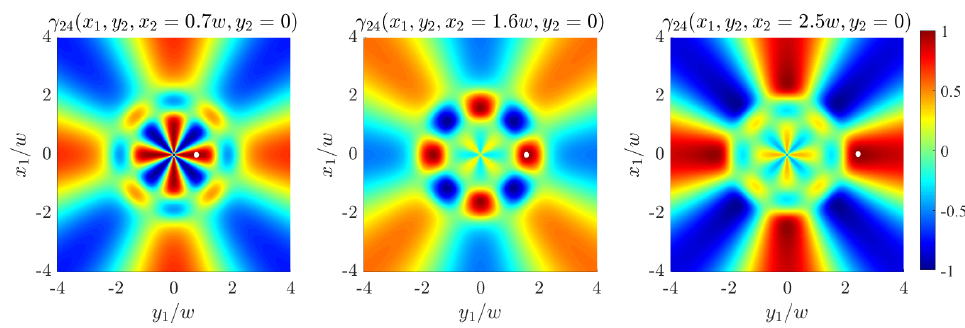
Figure 8. Degree of coherence for a source described by Equations (44) and (45), N = 2, m = 4, relative to three different points indicated by white dots and in the labels.